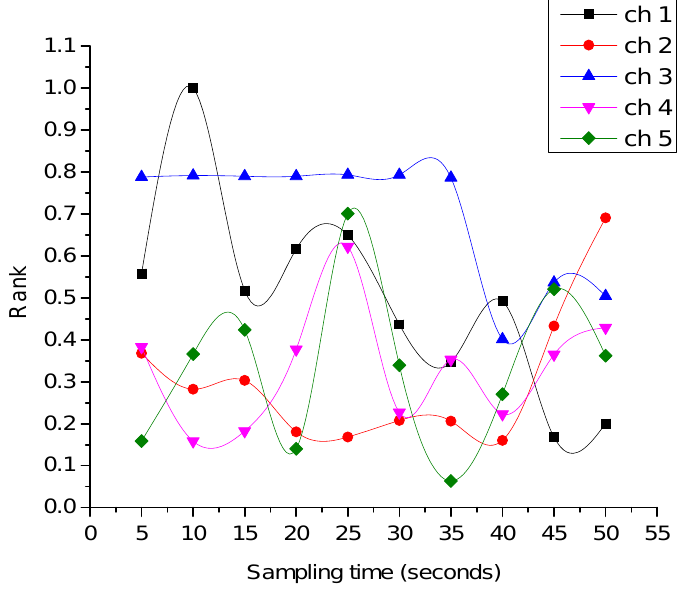
Figure 8. Dynamic behavior of channel ranks.